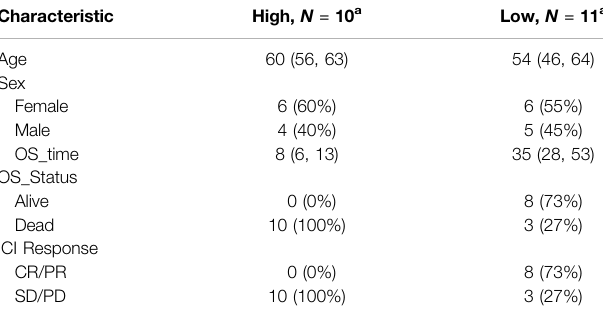
TABLE 3 | Characteristics of patients in low- and high-risk scores in MSKCC